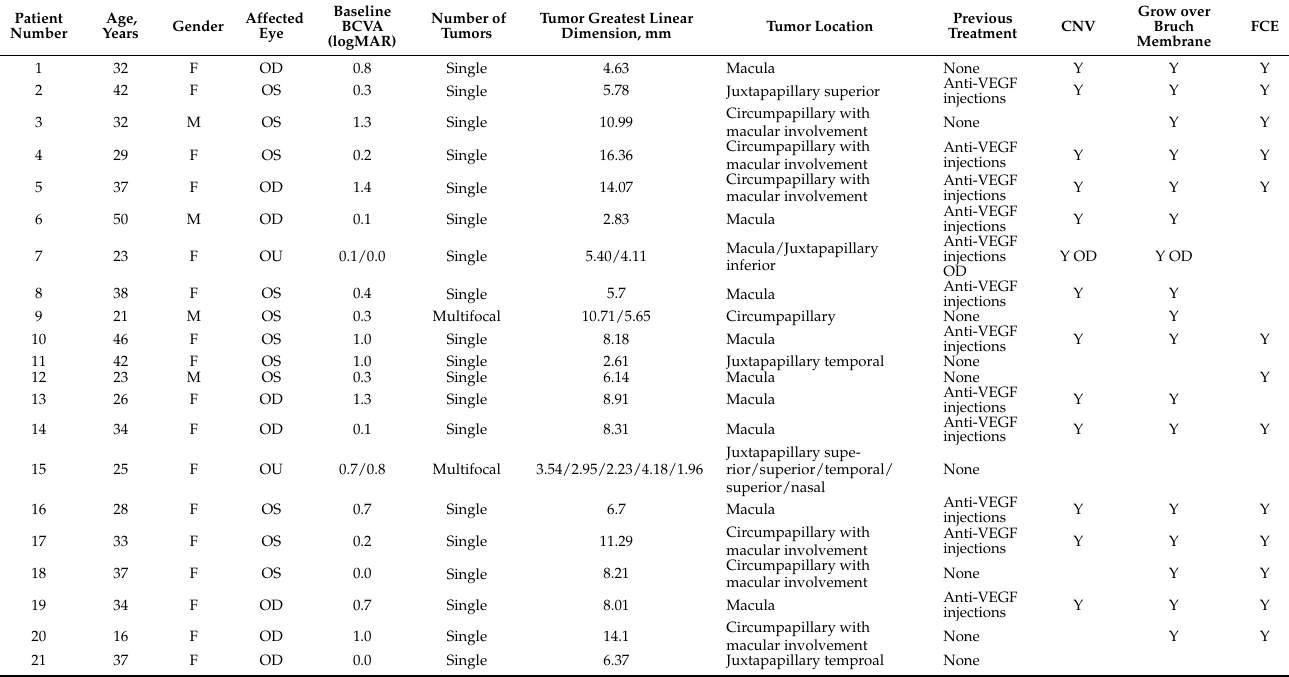
Table 1. Demographic and clinical features of patients with choroidal osteoma in the